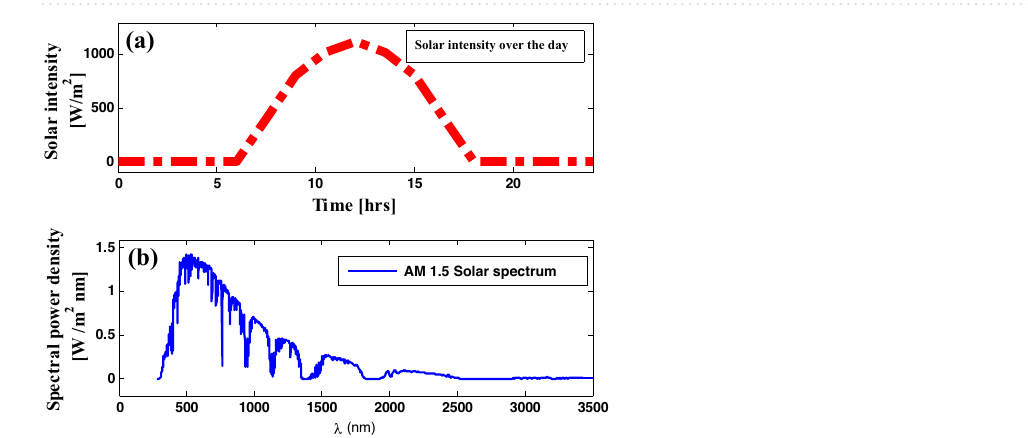
Figure 3. Cross-sectional temperature profile of the saline water sample surrounded by an acrylic wall on cloudy or winter days, the solar heat flux = 300 W/m 2 at different times as ( A ) Time = 0 min ( B ) Time = 30 min ( C ) Time = 60 min.